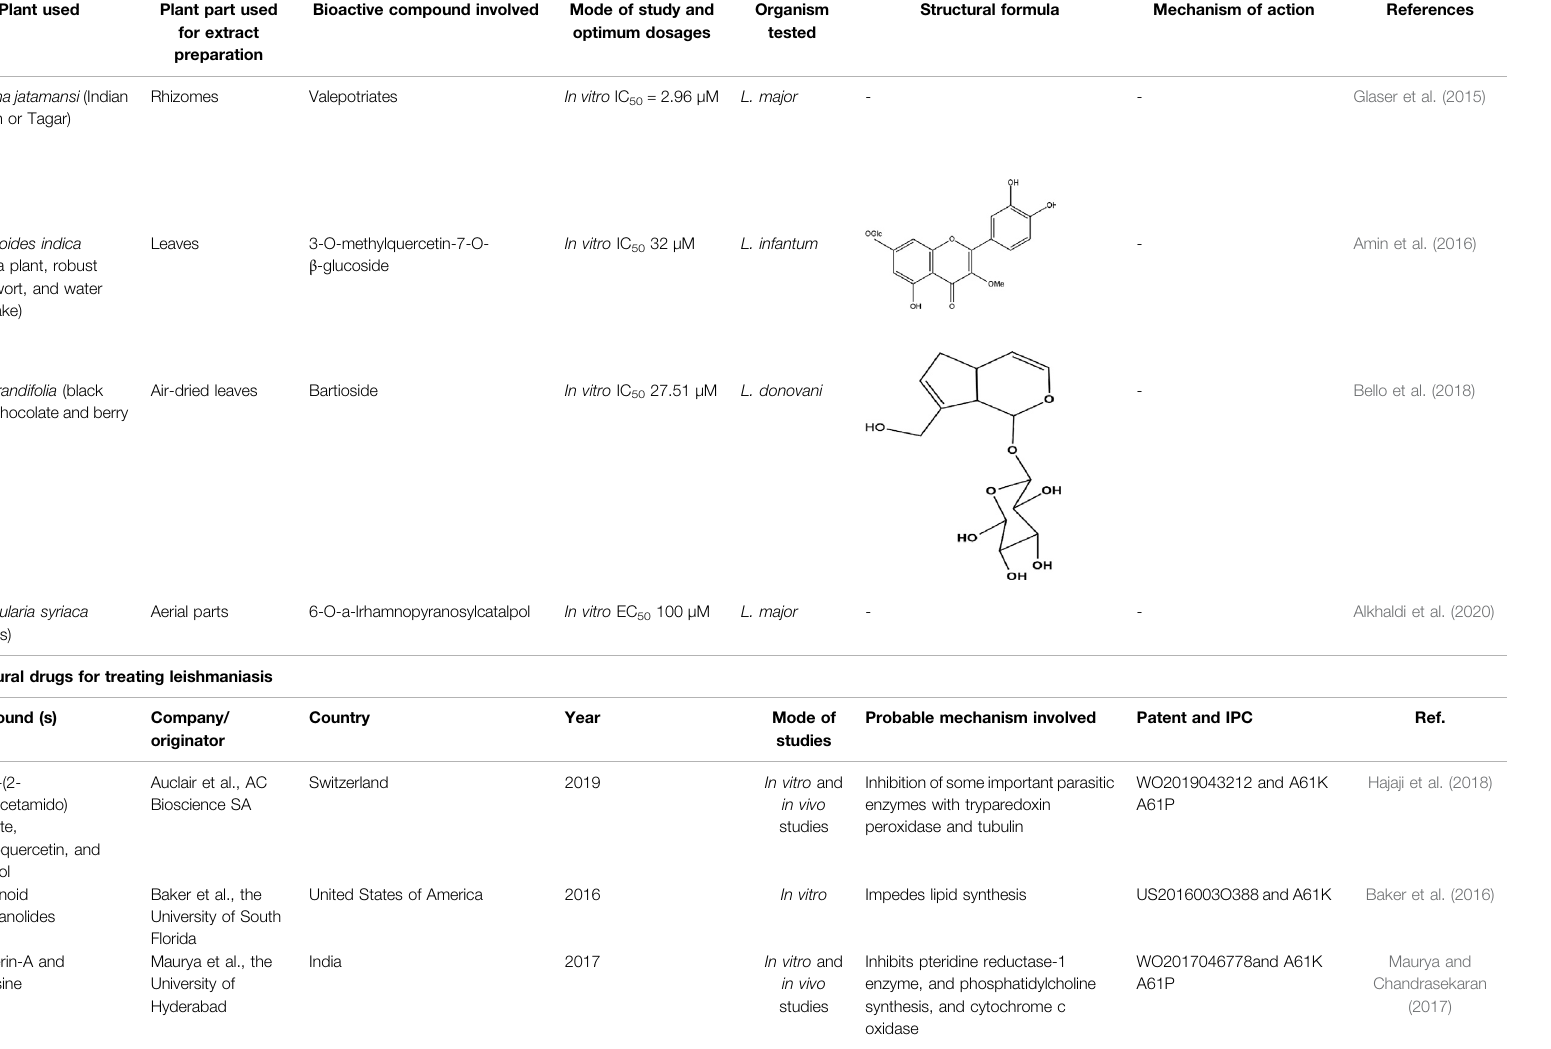
Section 2: Natural drugs for treating leishmaniasis Compound S. no